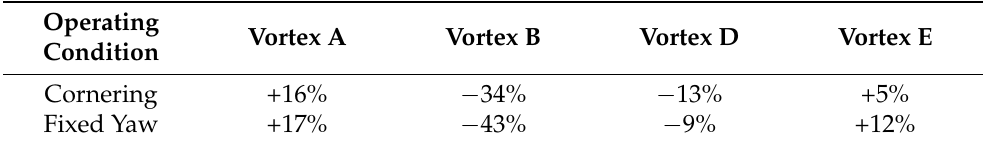
Table 4. A table showing the change in strength of the inboard flap tip vortices at x Wi /c = 1.624 under Table 3. A table showing the change in strength of the endplate vortices at x Wi /c = 1.019 under the the cornering and fixed yaw conditions relative to the straight-line condition. cornering and fixed yaw conditions relative to the straight-line